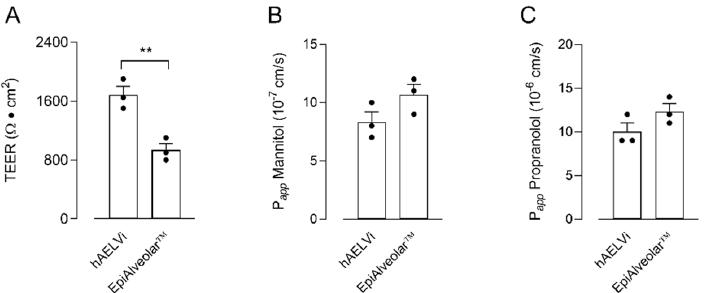
Figure 1. Transepithelial electrical resistance (TEER) and cellular permeability (P app ) in EpiAlveolar™ and hAELVi. TEER values (panel ( A )) and P app of mannitol (panel ( B )) and propranolol (panel ( C )) were measured in cells cultured under air–liquid interface (ALI) conditions, as described in Materials and Methods. Bars are the mean ± SEM of 3 independent determinations (single dots). ** p < 0.01 with a two-tailed Student's t-test.